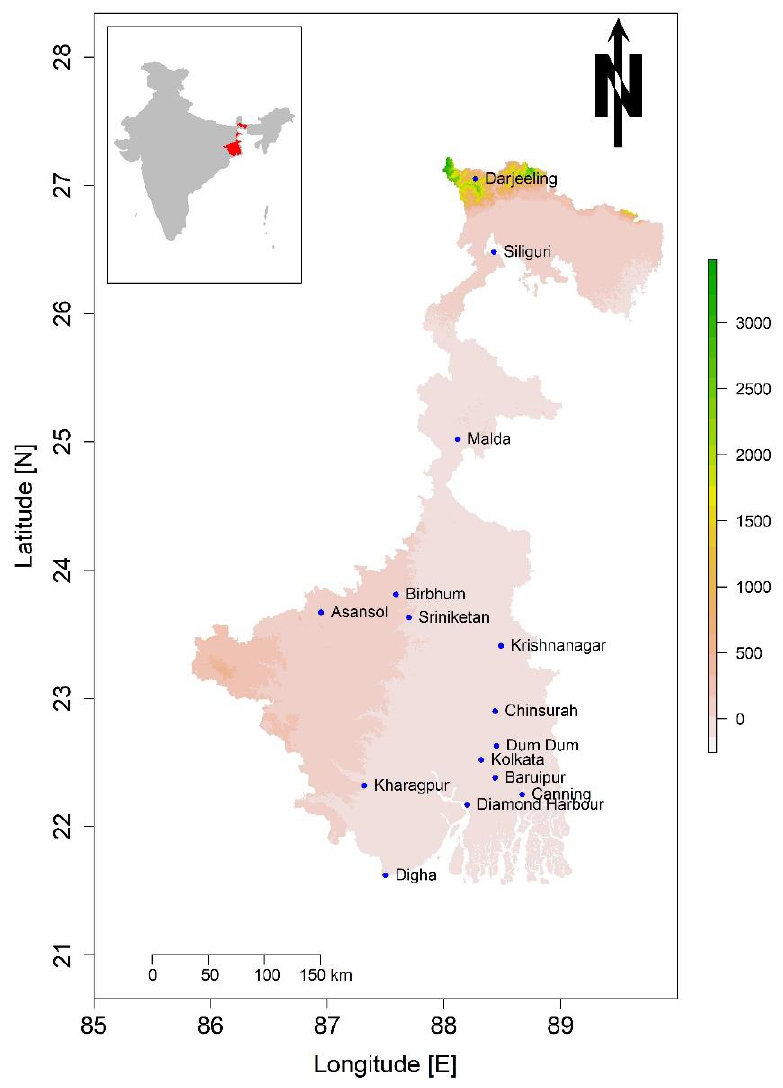
Figure 1. The considered 15 investigated sites are inscribed on the orography map of WB (WB). Inset: the political map of India. WB is highlighted (red) in the India map.